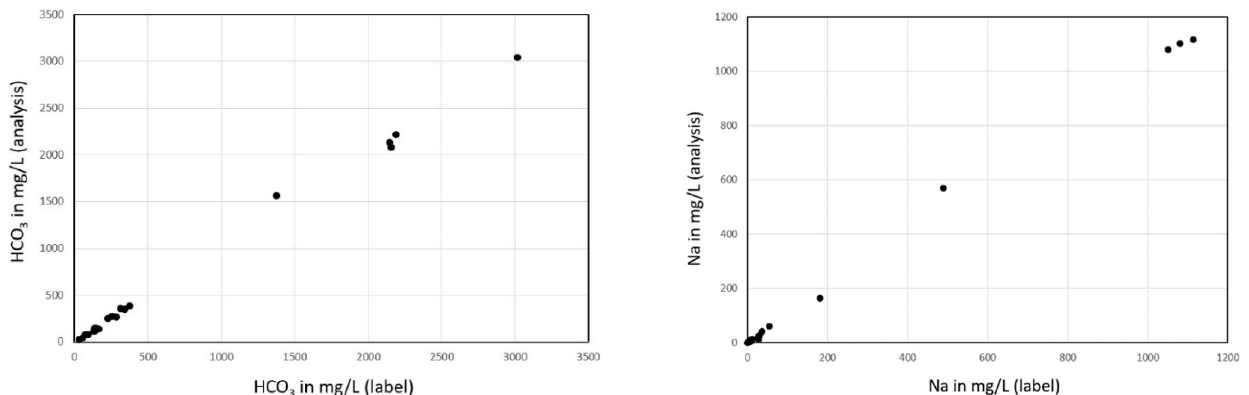
Figure 5. Comparison of our analytical results with the data given on the bottle labels for HCO 3 and